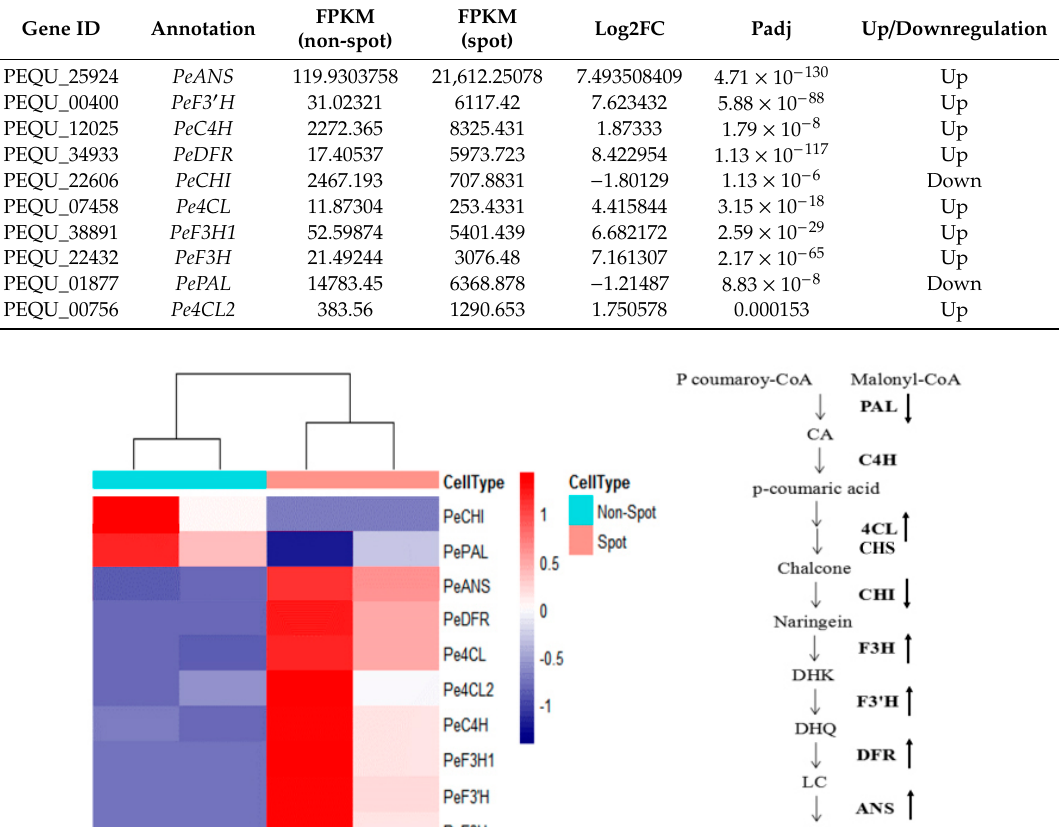
Table 2. Putative MBW genes identified from differentially expressed genes (DEGs).